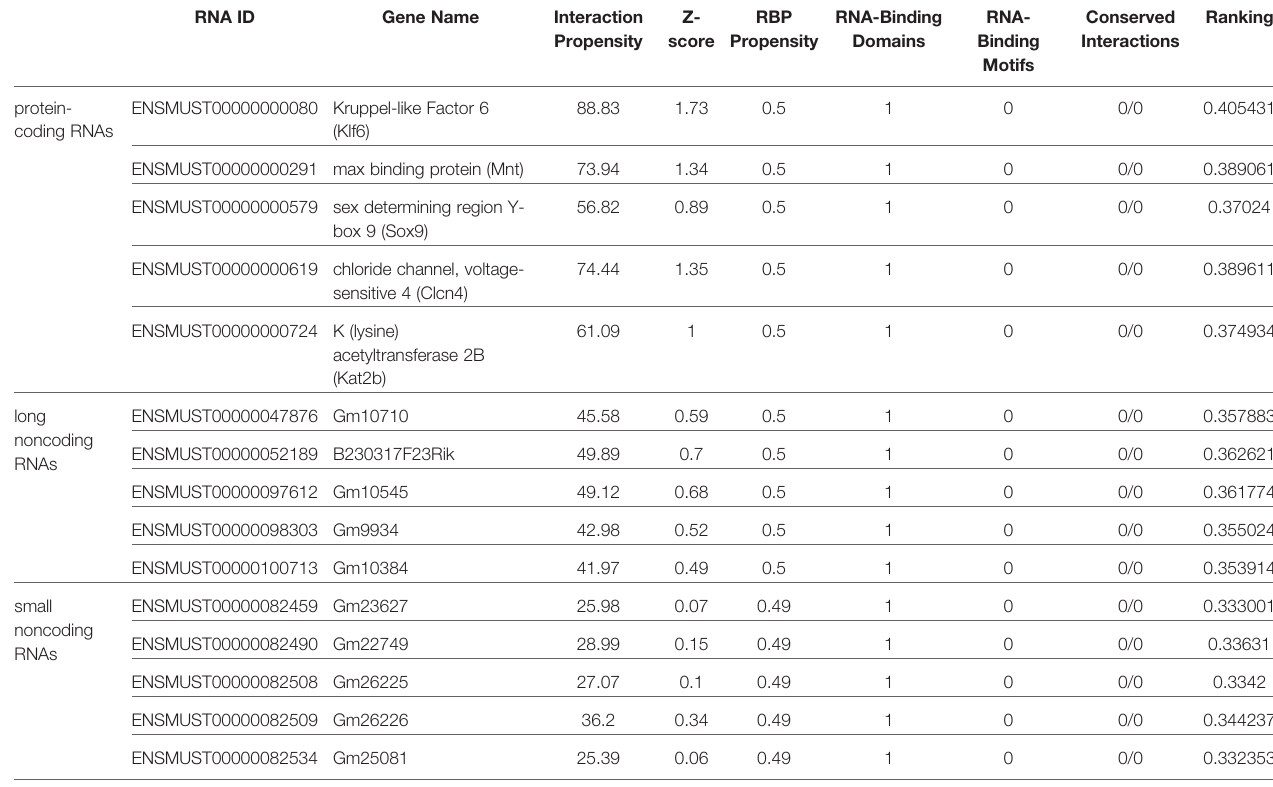
Table summarization of the top 5 predicted coding-RNA interactors (RNA ID and Gene Name) of murine-cGAS by catRAPID omics (version 2.0). The table shows Z-scores (interaction propensity normalization relative to experimental cases), discriminative ability (relative to training sets), interaction strength (enrichment relative to random interactions), the presence of RNA-binding domains, and RNA motifs. RNAs were ranked by the score, which is the sum of three individual values: 1) catRAPID normalized propensity, 2) RBP propensity and 3) presence of known RNA-binding motifs. The full score is